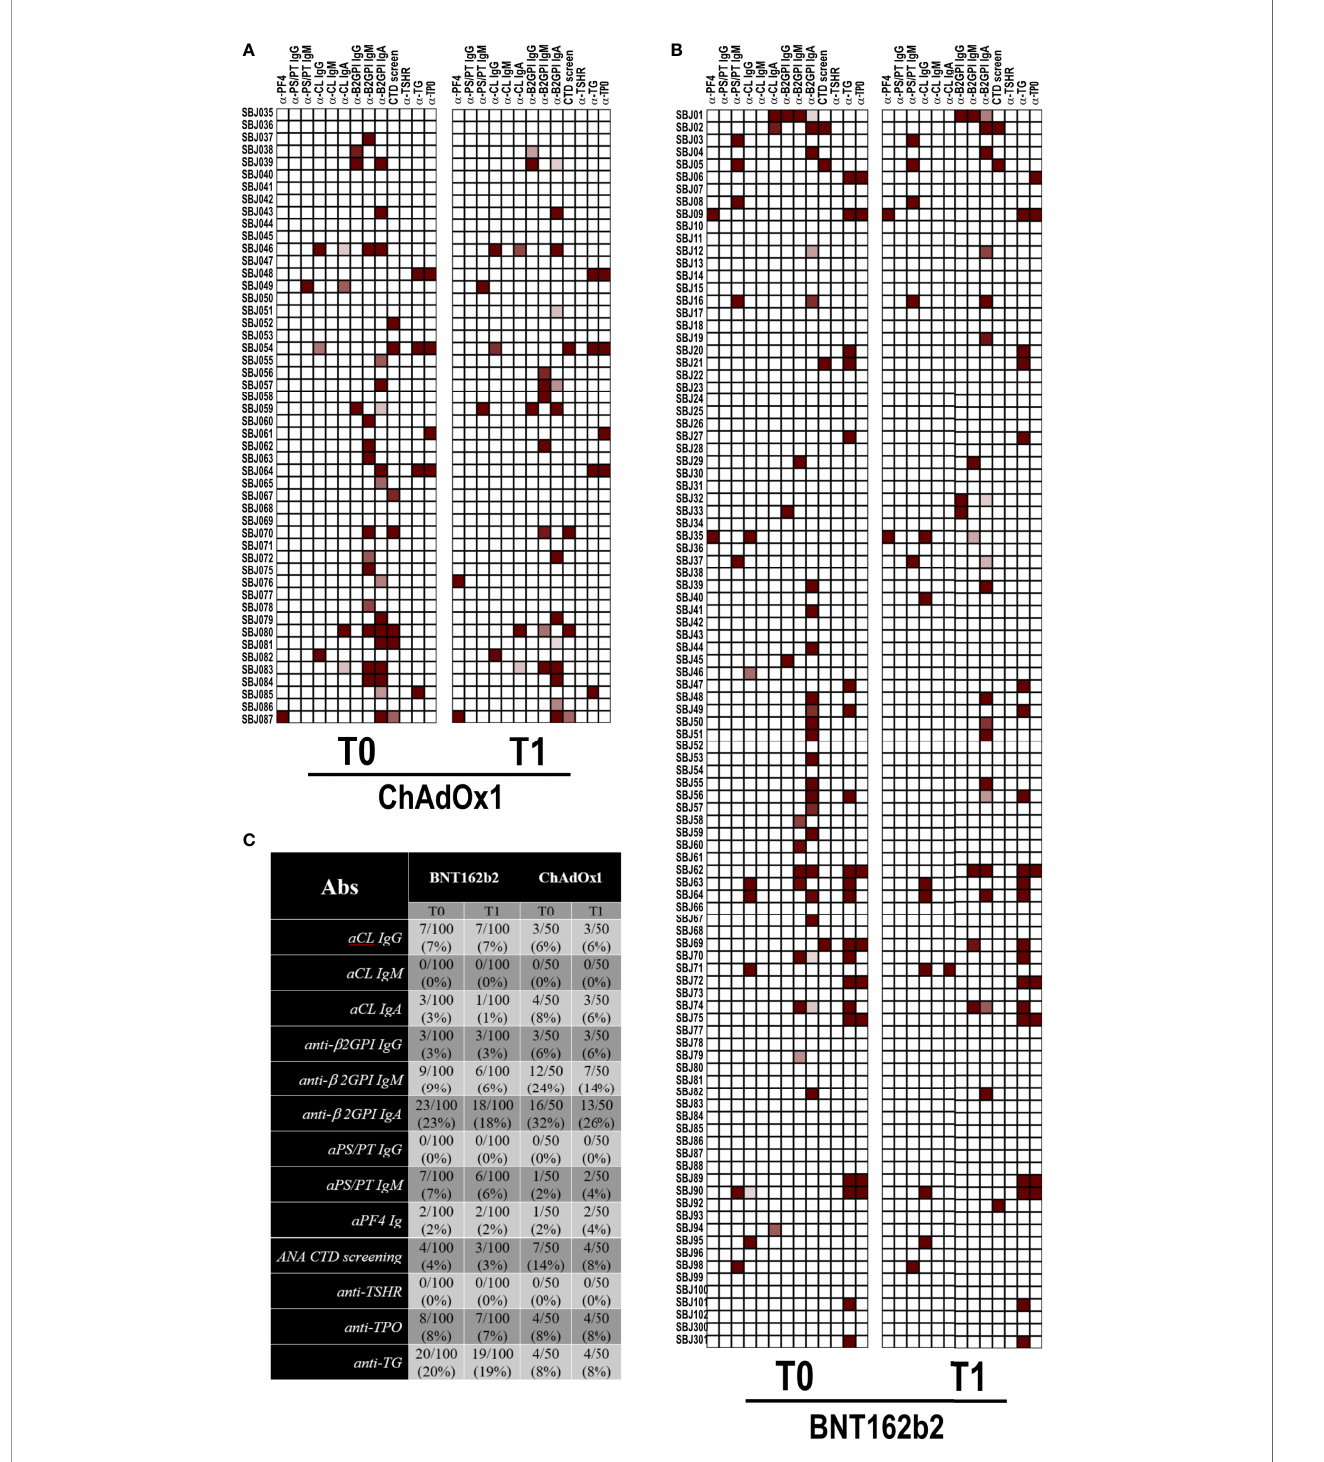
FIGURE 1 | Autoantibody reactivity pre- and post-vaccination by BNT162b2 or ChAdOX1. Heatmap showing serum IgG reactivity of individuals vaccinated with (A) ChAdOX1 or (B) BNT162b2 to the indicated autoantigens. In red are depicted the reactive subjects (arranged in rows) for each autoantigen (in column). (C) Frequencies of reactivity for each